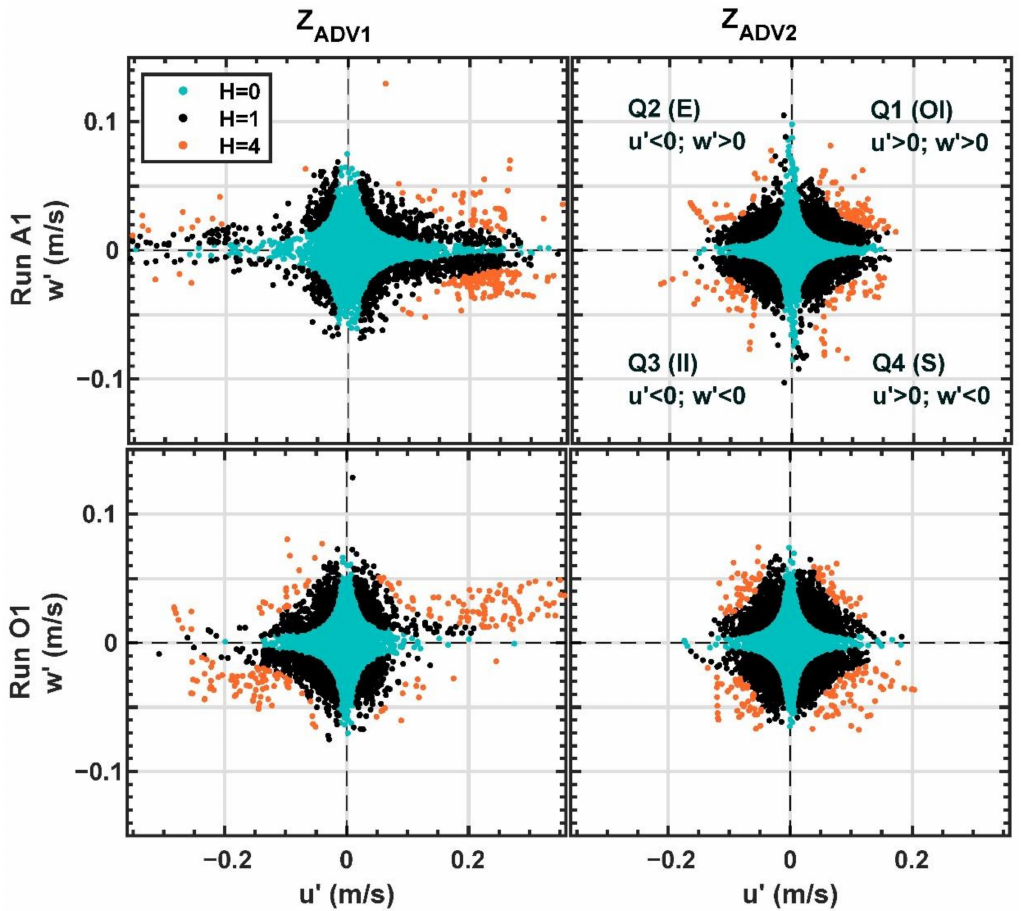
Figure 4. Unconditioned and conditional, instantaneous, joint probability density function of the streamwise-vertical Reynolds stresses (u (cid:48) w (cid:48) in (x–z)) plane, distributed across 4 quadrant types Q1 (Outward interaction, OI); Q2 (Ejection, E); Q3 (Inward Interaction, II); and Q4 (Sweep, S). The e ff ect of the threshold is shown for H = 1 and H = 4 (see text for information on colour coding).